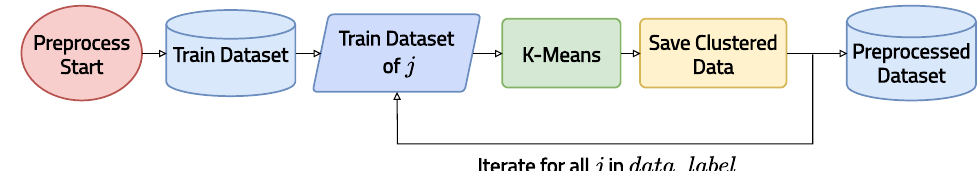
Figure 7. Overall algorithm of the